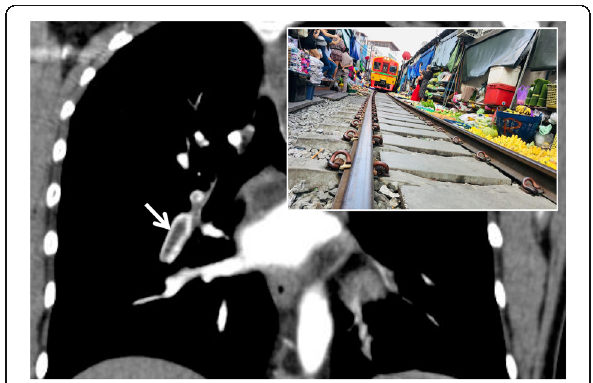
Fig. 28 Railway track sign. The coronal CT image well depicts linear and centric filling defect (white arrow) inside the lumen of an arterial lung vessel — due to acute embolism; the contrast, surrounding the central endoluminal defect of opacification, reproduces a railway track appearance. The railway track sign is very similar to the polo mint sign, which instead describes